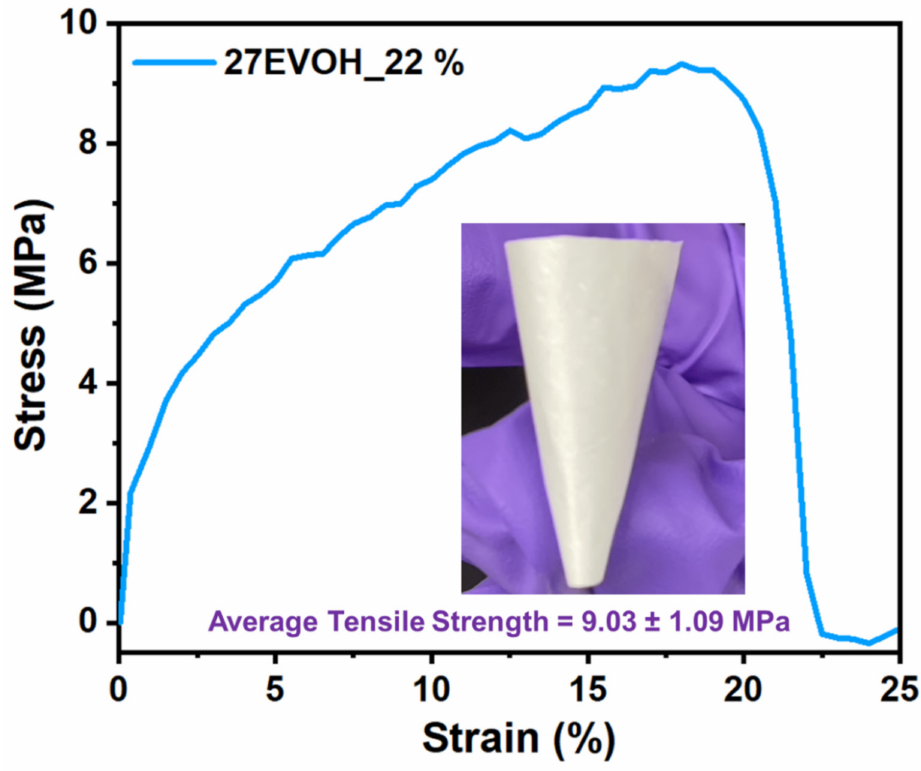
Figure 7. Stress–strain curve of the 27EVOH_22% membrane. The inset is a photograph of the bent electrospun